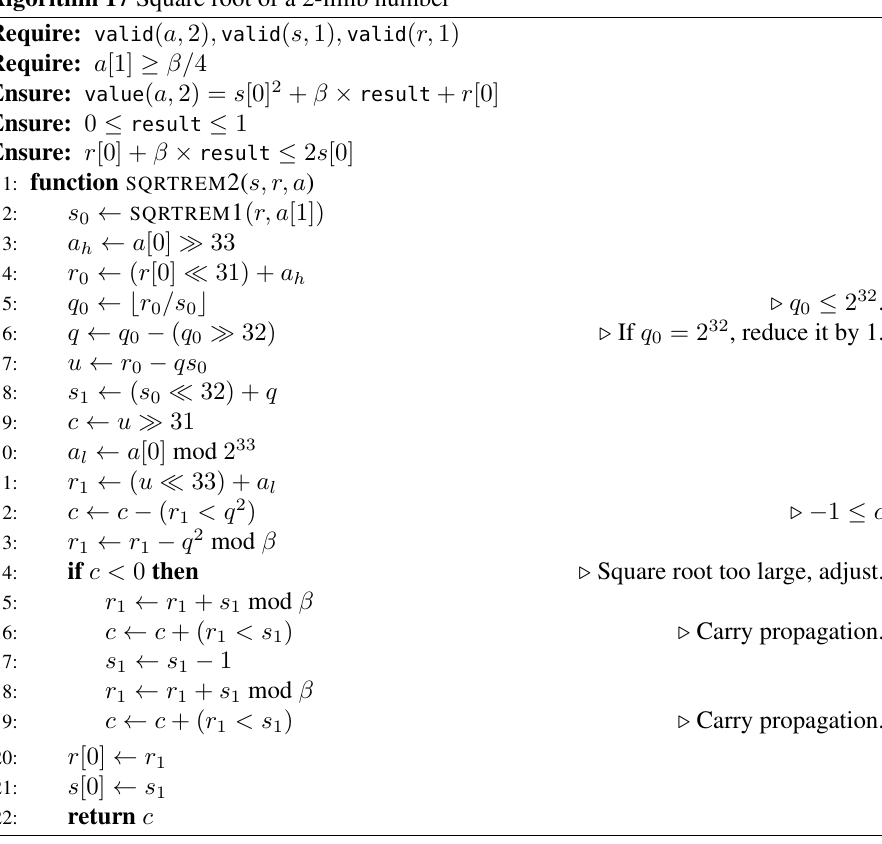
Algorithm 17 Square root of a 2-limb